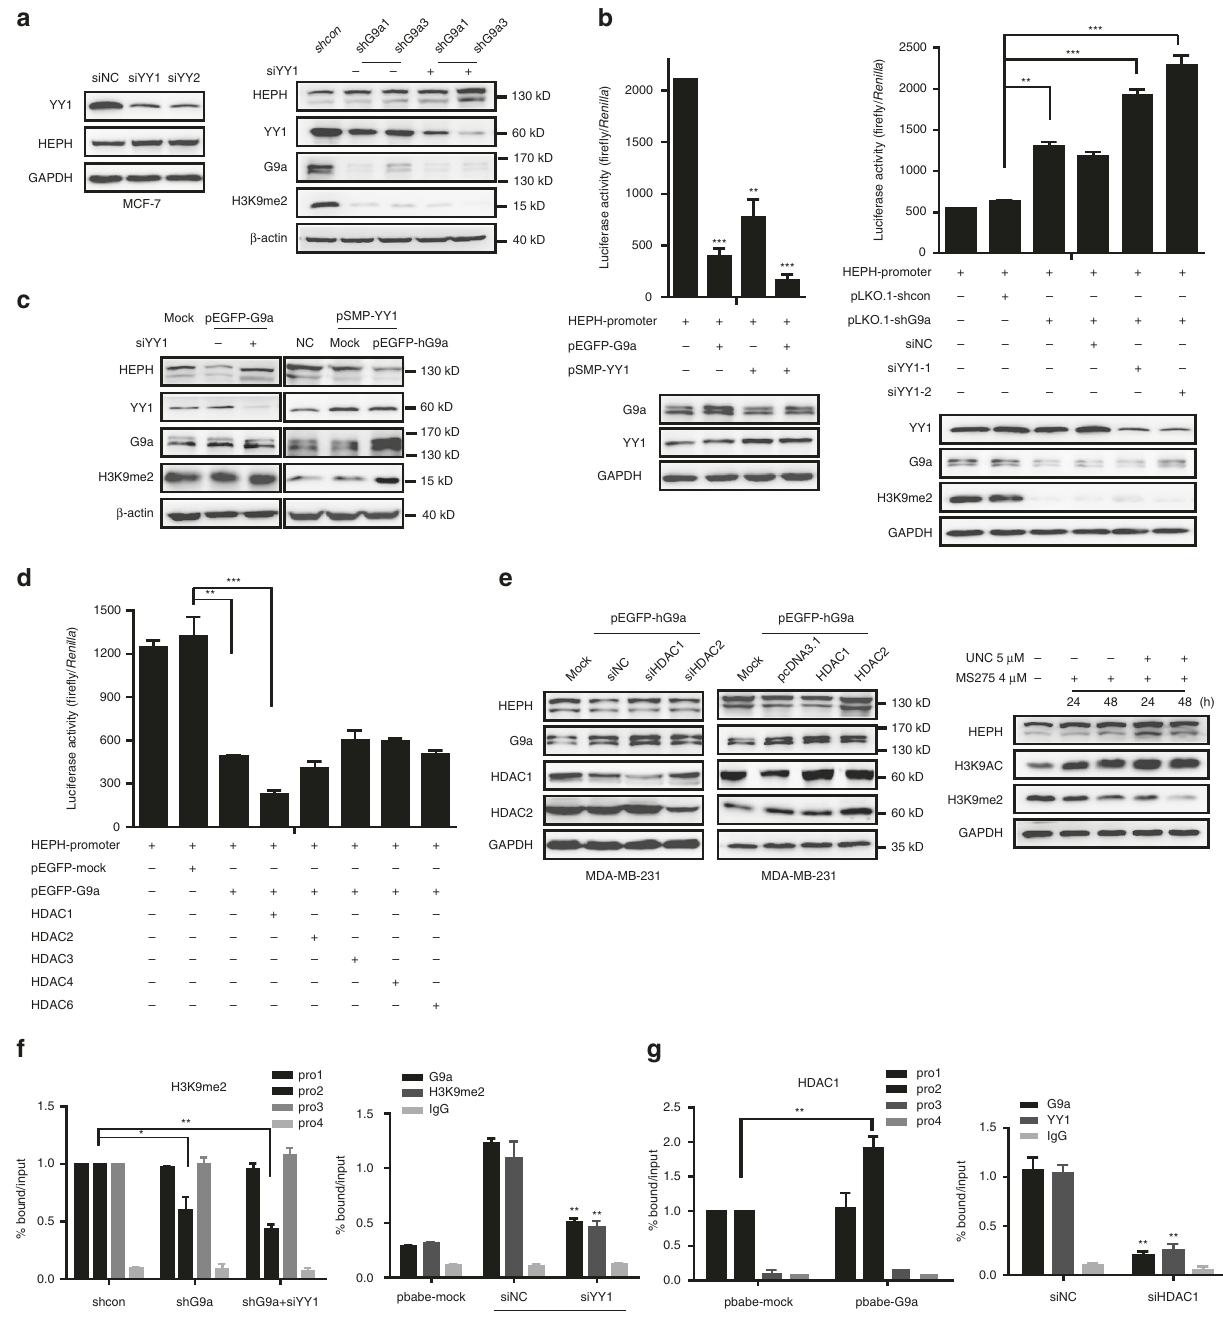
Fig. 6 G9a silences the expression of HEPH via assembling a co-repressor complex with YY1 and HDAC1. a – c MCF-7 cells were transfected with two independent YY1 siRNAs. After 48 h, HEPH protein and mRNA levels and HEPH promoter luciferase activity were examined. Expression of the transfected constructs is shown in the western blotting analysis. d pGL3- HEPH promoter and the indicated constructs were co-transfected into MDA-MB-231 cells. Twenty-four hours after transfection, cell extracts were assayed for luciferase activity. e Silencing and overexpression of HDAC1, but not HDAC2, contributed to the upregulation or downregulation of HEPH mRNA and protein level, respectively. The HDAC1-speci fi c inhibitor MS275 was synergetic with UNC0638 in increasing HEPH expression in a time-dependent manner. f , g The abundance of H3K9-me2 and the binding levels of G9a and HDAC1 in the Pro2 region of the HEPH promoter were determined by ChIP in G9a knockdown or overexpressed cells treated with siYY1. The results are presented as means ± SD from three independent experiments. Two-tailed unpaired Student ’ s T -test was performed. * P < 0.05, ** P < 0.01 and *** P < 0.001 Methods were purchased from Beyotime (Nantong, China). Monoclonal antibodies speci fi c Chemicals and antibodies . UNC0638 (#U4885) and BIX-01294 (#B9311) were for G9a (1:1,000; #3306), YY1 (1:1,000; #2185), HDAC1 (1:1,000; #34589), HDAC2 (1:1,000; #57156), Histone H3 (1:2,000; #4499), K9 dimethylated histone H3 both purchased from Sigma (St. Louis, MO, USA). The iron chelator DFO was (1:2,000; #4658), β -actin (1:5,000; #8457) and glyceraldehyde 3-phosphate from Novarits (Switzerland). FAC was from JK Chemical (#F5879, Shanghai, dehydrogenase (GAPDH) (1:5,000; #5174) were purchased from Cell Signaling Inc. China). Kits of the membrane and cytosol protein extraction kit (#P0033), the ROS (Danvers, MA, USA). The other antibodies were as follows: HEPH antibody (1:500; assay (#S0033) and the cell lysis buffer radio-immunoprecipitation assay (#P0013B) NATURE COMMUNICATIONS | 8: 274 | DOI: 10.1038/s41467-017-00350-9 |